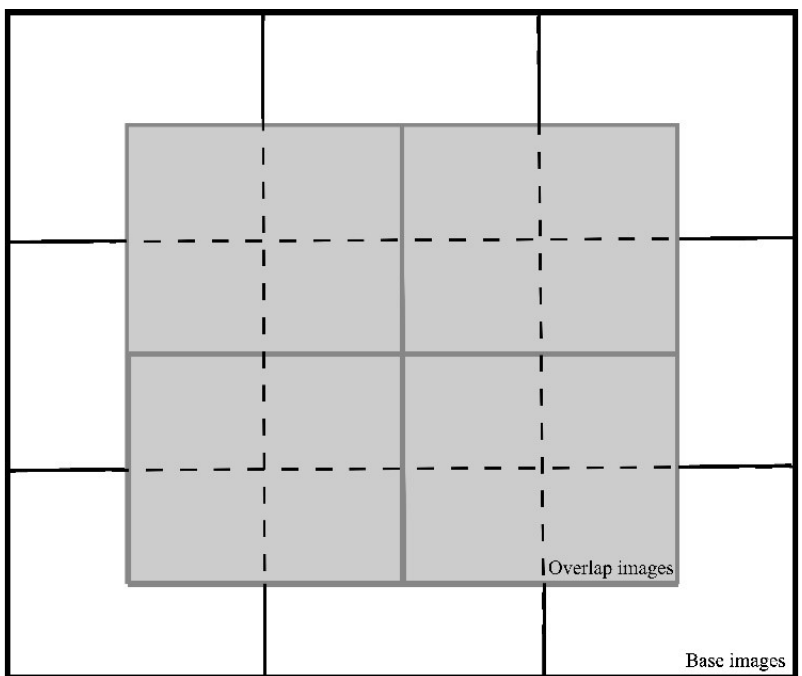
Figure 5. Graphical representation of the individual image sections. The bold black outline repre- sents a single satellite image. The no fill squares surrounded by thin and dashed black lines are the base images. The gray fill squares are the overlap images.